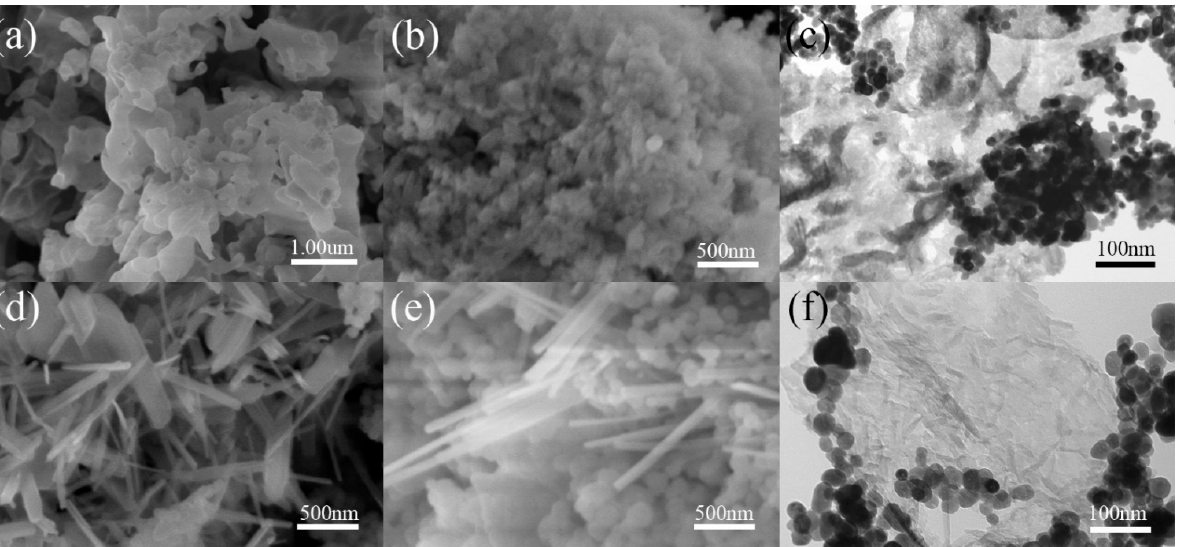
Figure 1. XRD patterns of ( a ) g-C 3 N 4 , LaVO 4 , and 10–50%LaVO 4 /g-C 3 N 4 , ( b ) g-C 3 N 4 , GdVO 4 , and 10–50%GdVO 4 /g-C 3 N 4